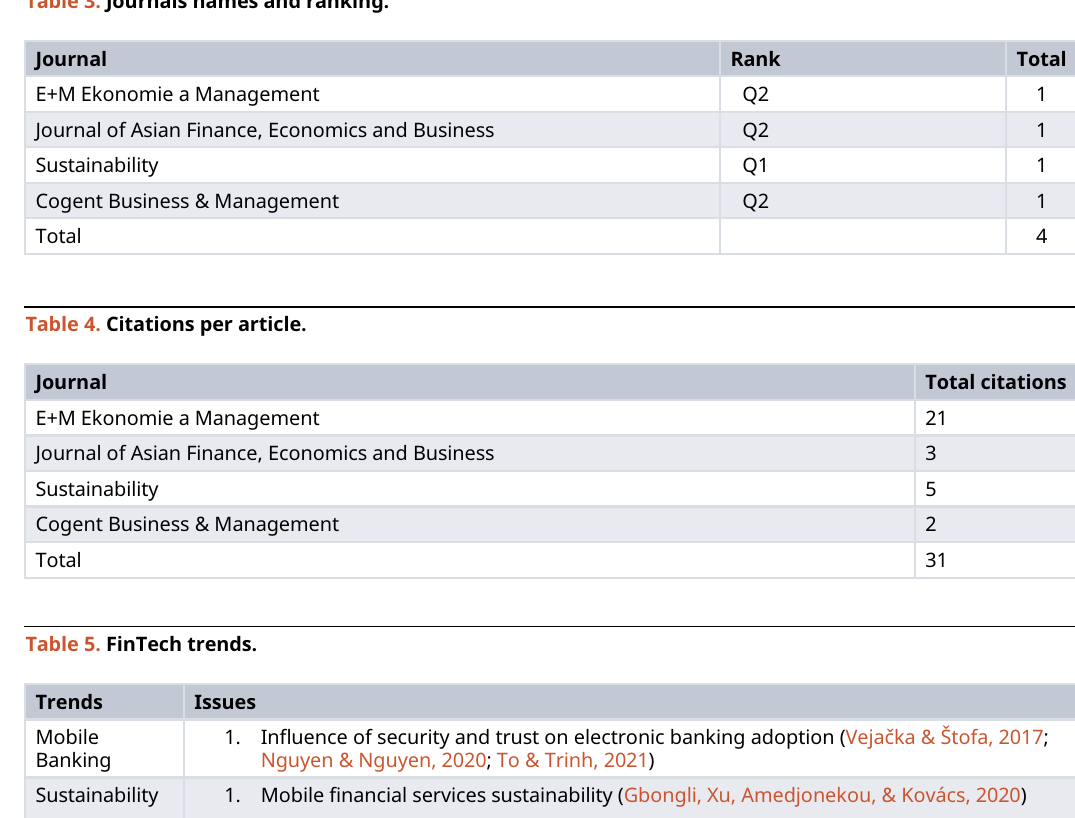
Table 3. Journals names and ranking.